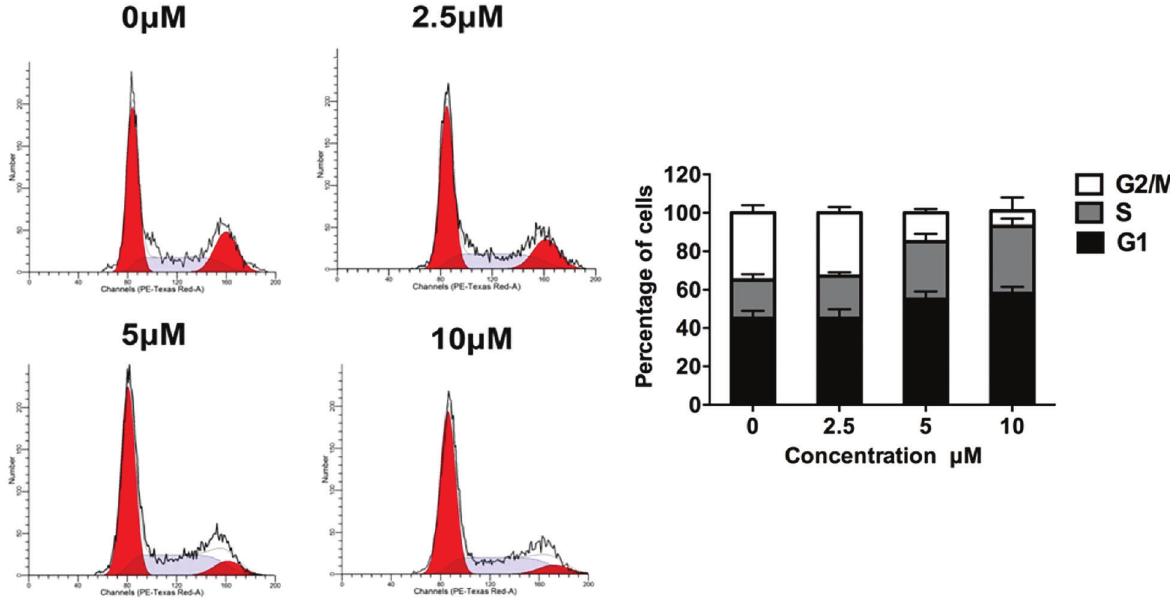
Figure 2. Cantharidin decreased the cell percentage in G2/M phase but increased that in S and G1 phases. This observation was also seen in higher doses of cantharidin treatment. Data are reported as means ±